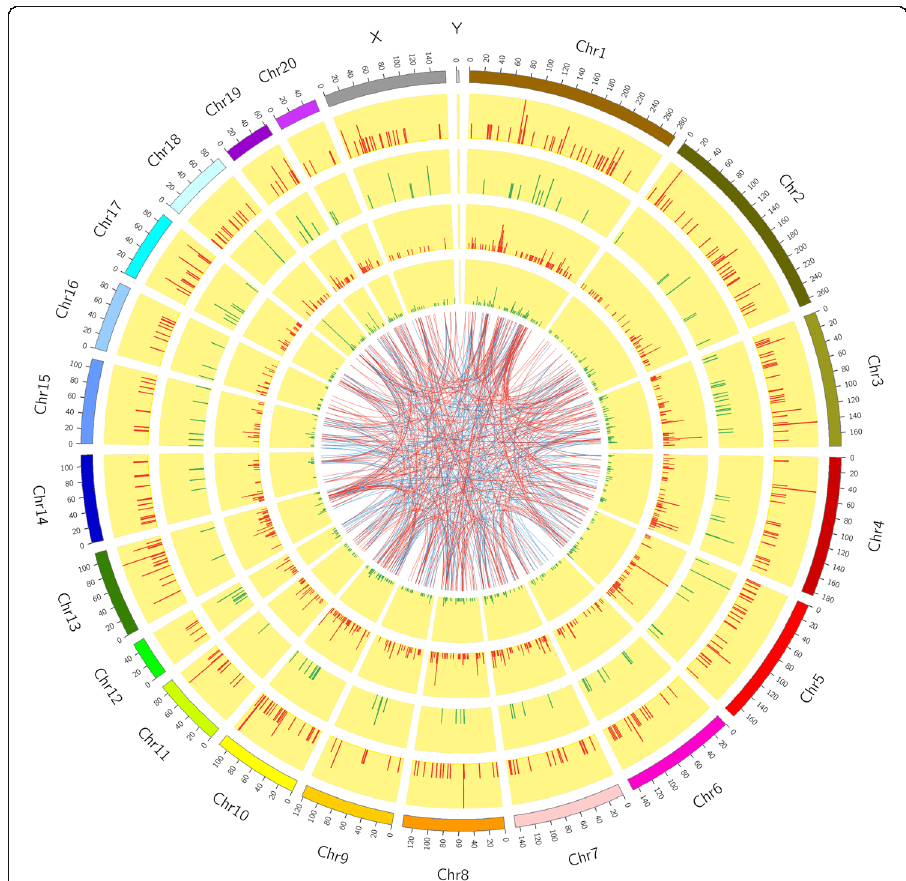
Fig. 3 The outermost circle is the autosomal distribution map. The second and third circles are the distribution of differentially expressed genes on chromosomes. The red lines are upregulated and the green lines are downregulated. The higher the column, the more differentially expressed genes are in the region. The fourth and fifth circles are the distribution of differentially expressed lncRNAs on chromosomes. The expression form is related to the expression of RNA. The internal connection indicates that Top500 co- expresses the corresponding relationship between lncRNAs and mRNAs. Red indicates a positive correlation and blue indicates a negative